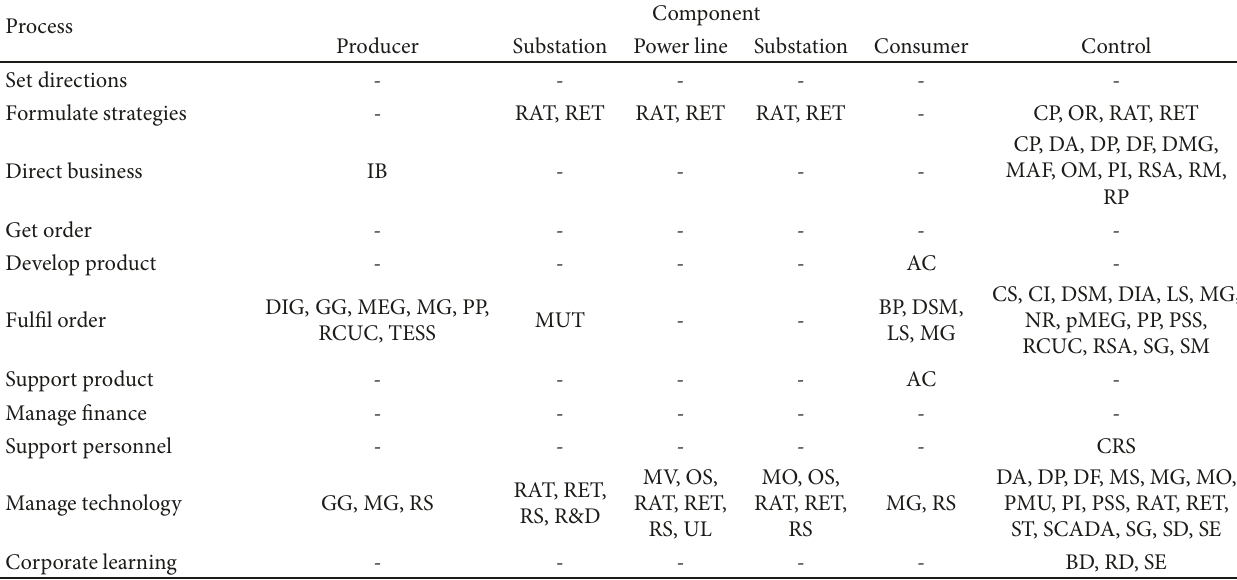
Table 4: Index of tools for resilience enhancement of a power grid; tools are referred as abbreviations of their